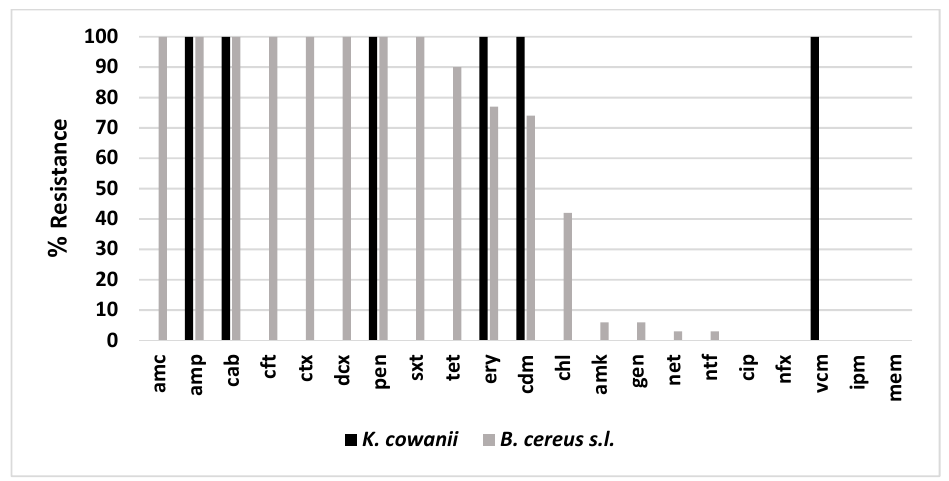
Figure 3. Antibiotic resistance profile. The bar graph represents the percentage of the isolates of each bacterial species that were resistant to a particular antibiotic tested.